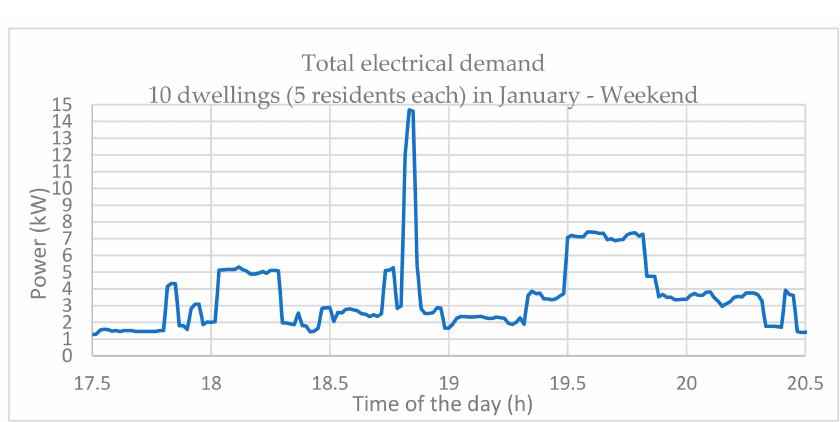
Figure 12. 3 h (17:30–20:30) total electrical demand—Profile